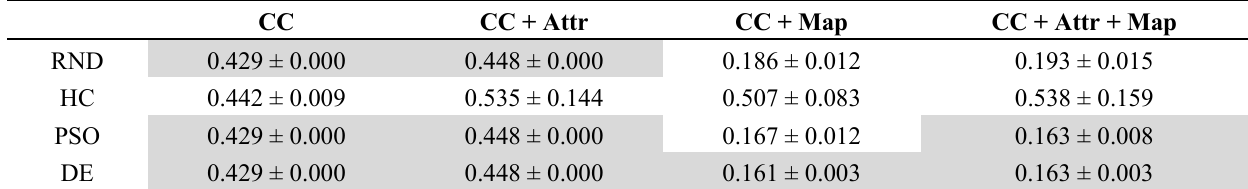
Table 7. Performance of the four search methods on the four method variants. In the simpler CC method variants (CC and CC + Attr), no benefit is noted from using more advanced search methods. In the case of the higher dimensional method variants (CC + Map and CC + Attr + Map), using an advanced search method becomes